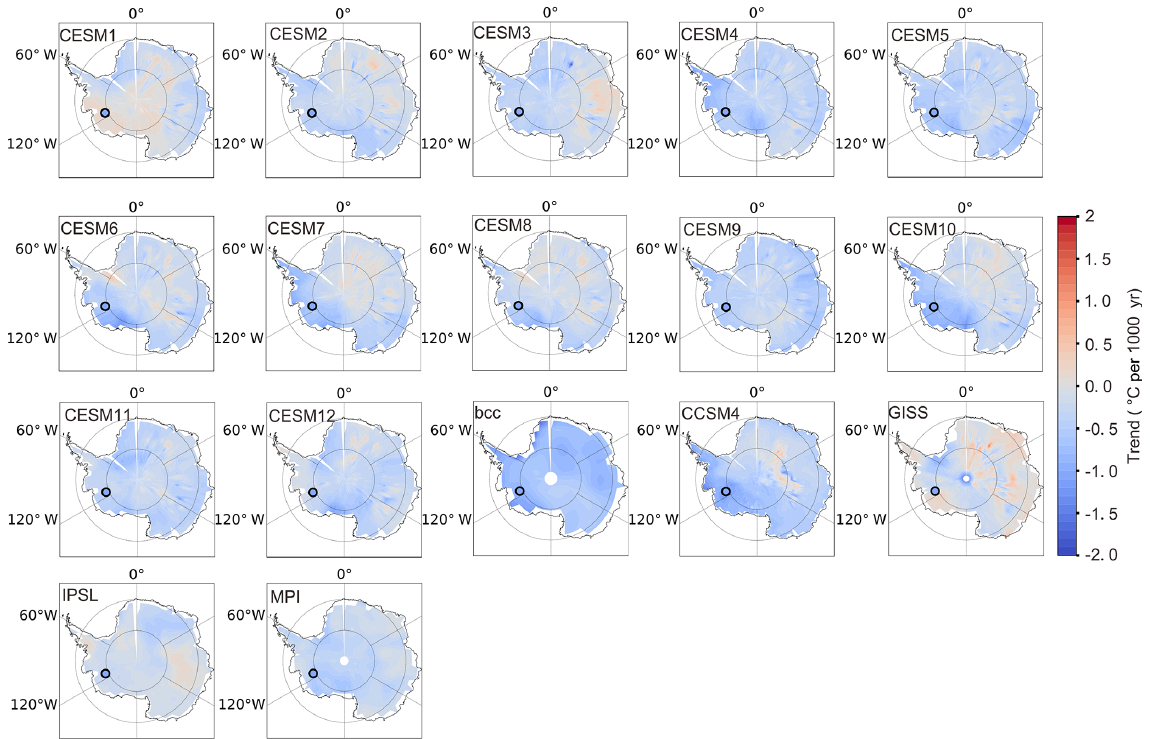
Figure 6. The simulated (blue to red shaded area) and observed (circle) surface temperature trend from 1000 to 1600CE in Antarctica.